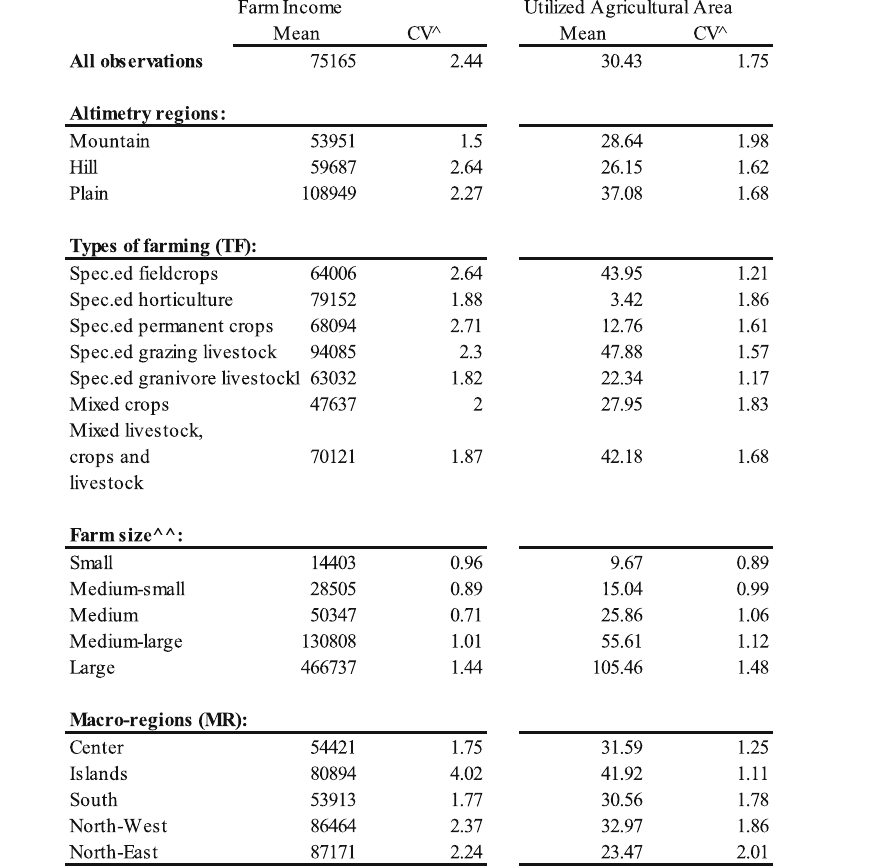
Table 6 Average farm size in terms of farm income (Euro/farm) and utilized agricultural area (ha/ farm) in the sampled farms. Whole sample, and farms grouped by: altimetry regions, types of farming, farm size, and macro-regions of Italy. Balanced sample (year 2015). Mean values and coefficients of variation (CV) within the